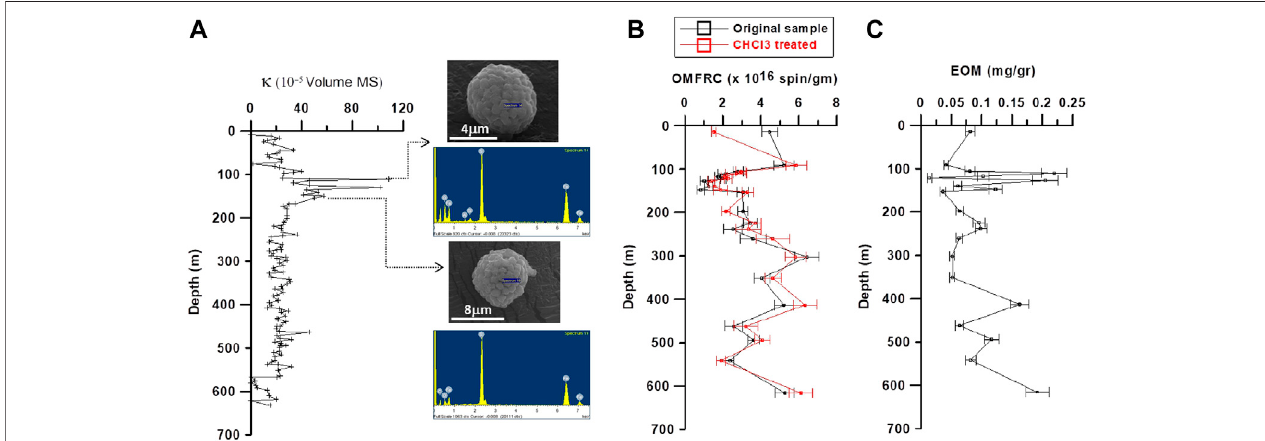
FIGURE 3 | Comparative pro fi les for the fi rst 600 m of the stratigraphic well Saltarin 1A. (A) Bulk magnetic susceptibility ( κ ). The insets show the scanning electron microscope (SEM) photomicrographs and results of Energy Dispersive X-Ray analyses (EDX) of hydrocarbon-related Fe and S-rich framboids, identi fi ed at 127.4 and 147.2 m,withinGuayabo ’ sG5anomalousmagneticsusceptibilitypeak(afterCostanzo-Álvarezetal.,2012). (B) Concentrationsoforganicmatterfreeradicals(OMFRC) for both chloroform-treated and untreated samples, obtained from the Electron Paramagnetic Resonance (EPR) experiments. (C) Concentrations of extractable organic matter